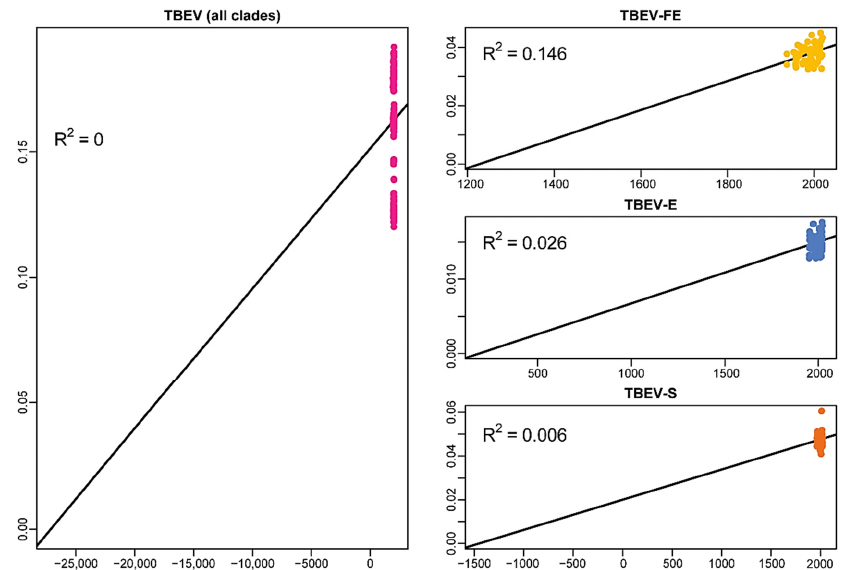
Figure 1. Root ‐ to ‐ tips regression analysis indicating a correlation between genetic distances from a root to tree tips and collection dates of samples. The X ‐ axes represent calendar years where negative values are years BC. The abbreviates in the titles of windows are the common tick ‐ borne encephalitis virus clade (TBEV ‐ common) and TBEV subtypes: Far ‐ Eastern ( ‐ FE), European ( ‐ E), and Siberian ( ‐ S).